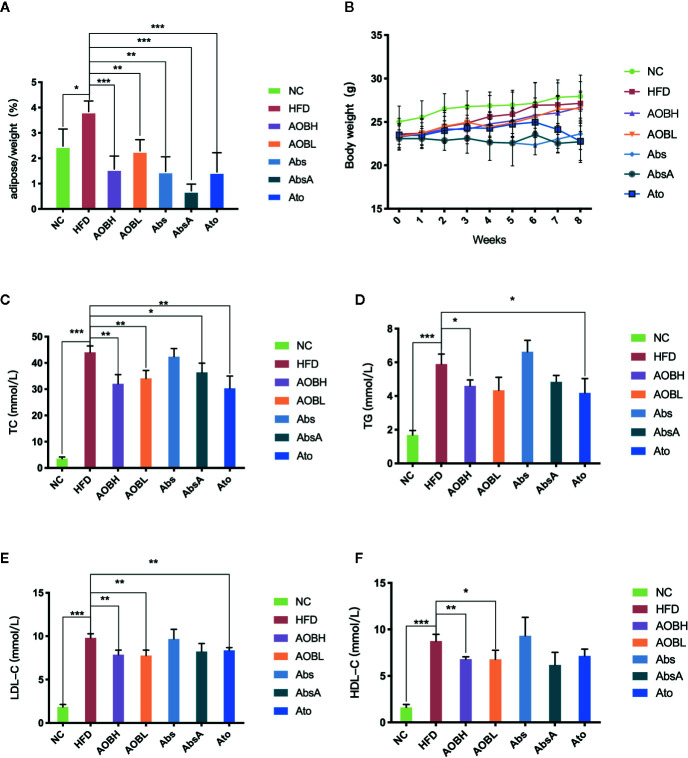
AOB decreased the amount of tissue and lipid content in adipose. (A) The ratio of adipose body tissue mass at the ends of the week. (B) Growth curves given the average body weight of the seven groups calculated per week. (C) TC, (D) TG, (E) LDL-C, and (F) HDL-C levels at 8 weeks in serum samples of the seven groups of mice. Values are shown as the ± standard mean deviation. ANOVA calculated disparities. Compared to the HFD community, *p < 0.05, **p < 0.01, ***p < 0.001.